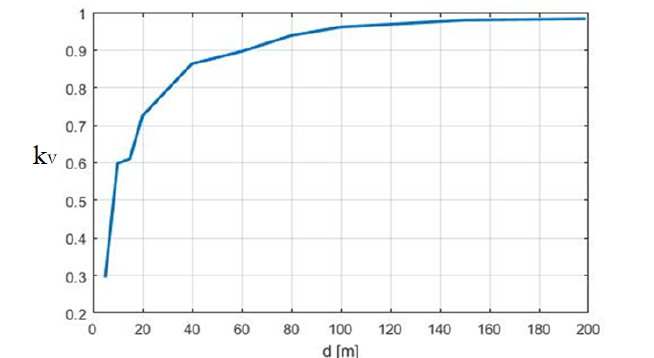
Figure 9. Ratio between the maximum voltage induced on the line considering or not considering the presence of a building. (A) H = 20 m, and d varies from 5 to 200